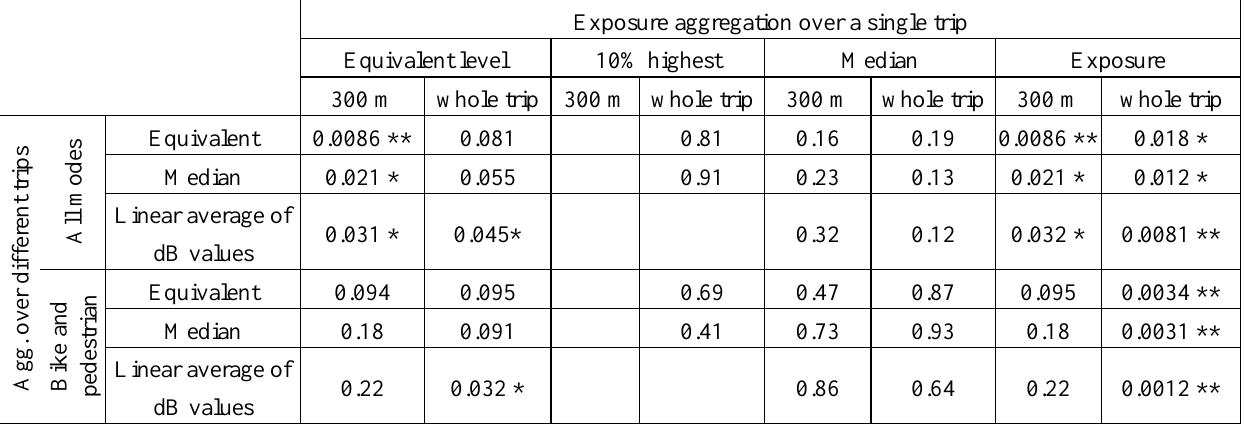
on the most exposed day is 0.013. day,facade